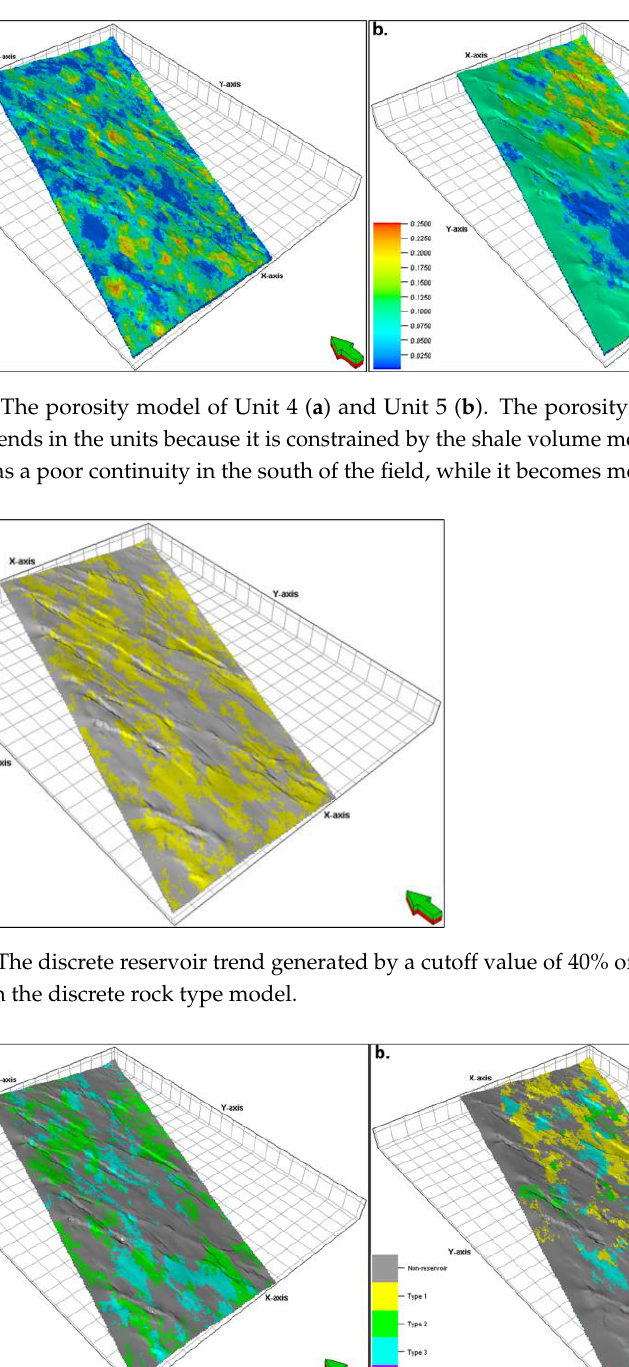
Figure 19. SW – NE intersections of rock type model of Unit 4 ( a ) and Unit 5 ( b ). The rock type shows inverse variation trends in Unit 4 and Unit 5. Rock type 1, which has the best reservoir quality, only exists in the conventional gas reservoir in Unit 5. Different φ -k relations are a common indicator of different reservoir rock types [37 – 41] . The permeability model is calculated based on the φ -k relations of the four rock types (Figure 20). The permeability model also presents the inverse trends of reservoir quality